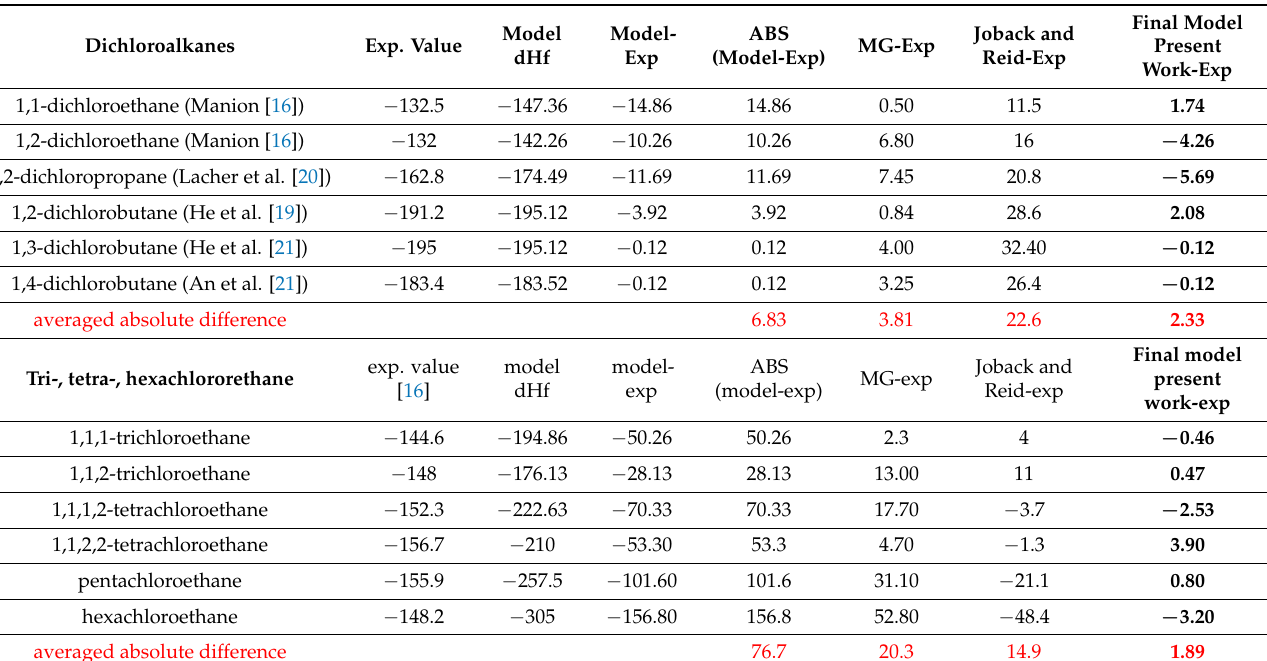
Table 3. Experimental and model values for multiple chlorosubstituted alkanes. All values are in kJ/mol. The origin of the experimental values is given in column 1. The final model of the present work (last column) values are based on Equation (3), complemented with neighbor interactions of the type 1,1-dichloro and 1,2-dichloro (for an explanation, see the